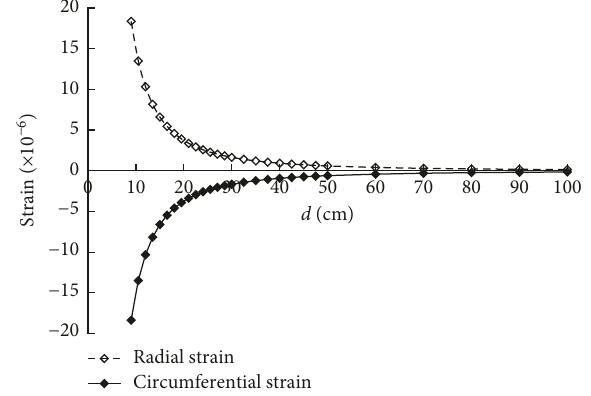
Figure 3: Calculation results of surface strain of the CC pavement structure model.